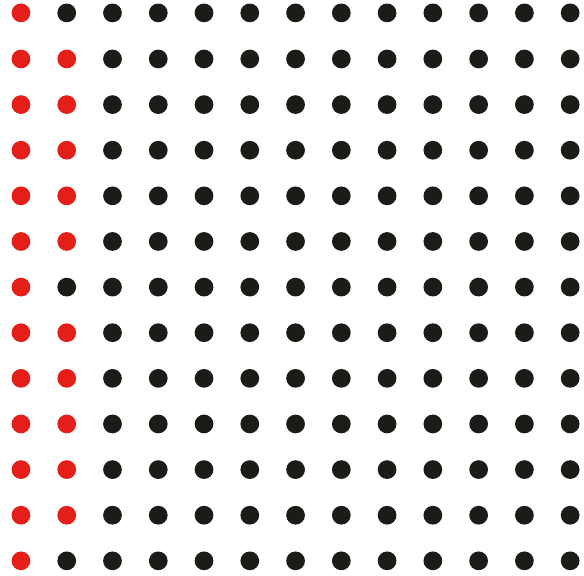
Figure 28: Schematic diagram of uplifted nodes with the soil shear wave 2000 m/s under EL wave for HV case (65 nodes uplifted and uplift area ratio is 33.3%).